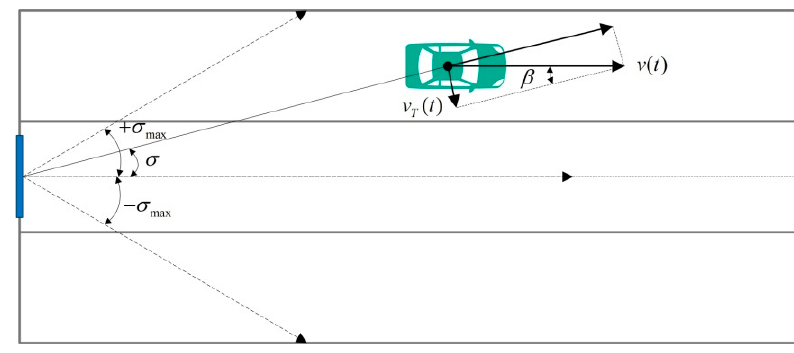
Figure 5. Angle measurement of vehicles.